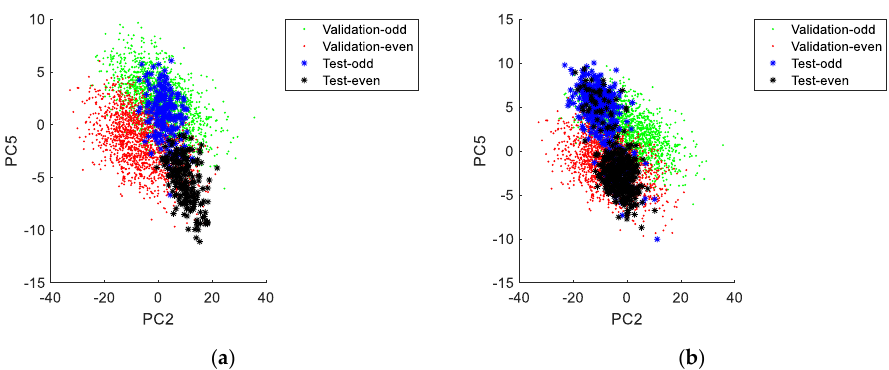
Figure 12. Relation between the principal components of the simulated validation lots and the data from CS2: ( a ) first and second principal components; ( b ) first and fourth principal components; ( c ) third and fourth principal components; ( d ) fourth and fifth principal components.